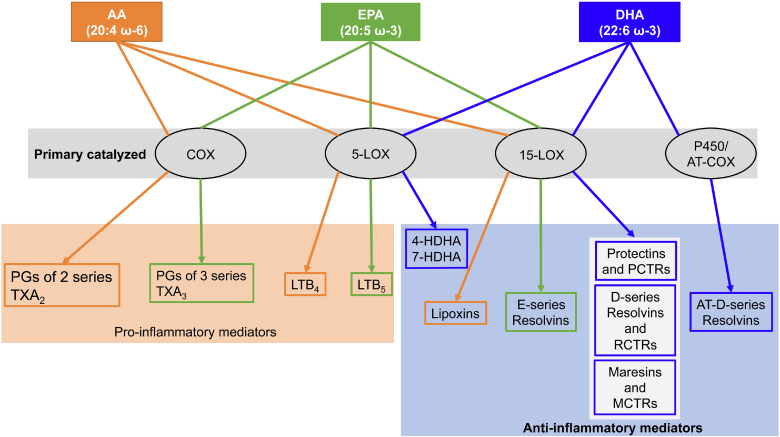
Lipid mediators derived from the three most abundant essential fatty acids, AA, EPA, and DHA, esterified in the sn-2 position of the phospholipids. Depending on the primary catalyzing enzyme, COX-2, and 5- and 15-LOXs, there is synthesis of a variety of bioactive lipids involved in inflammation as well as in resolution of the inflammatory response. Mediators from AA are highlighted in orange, EPA in green, and DHA in blue.